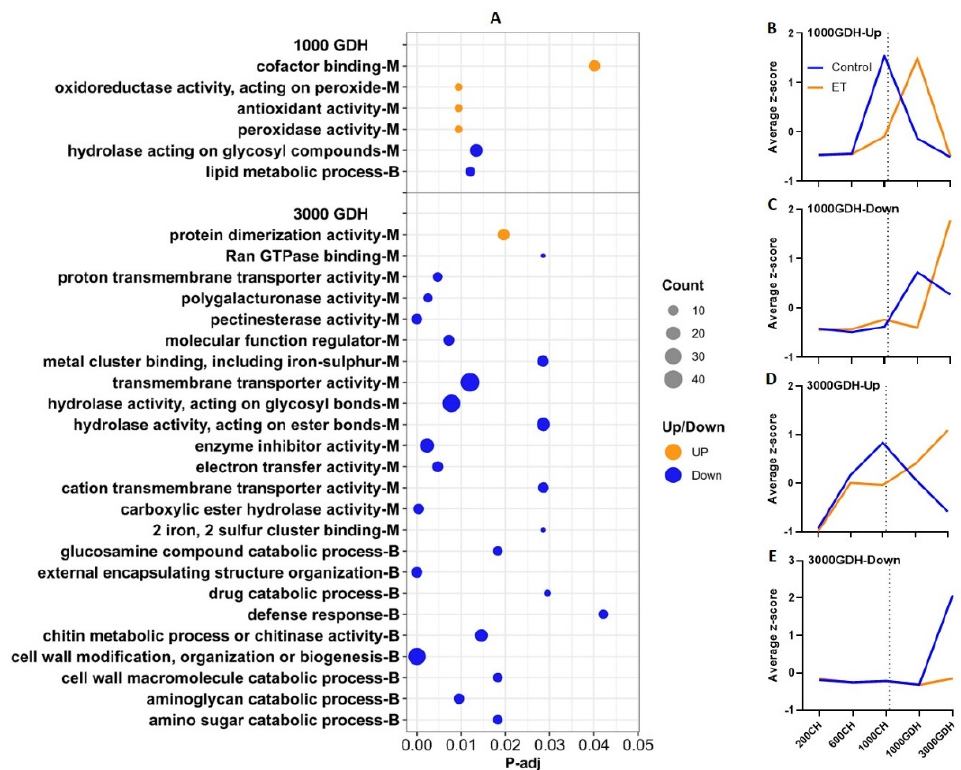
Figure 6. Enrichment analysis of DEGs between the ET treatment and the control of peach cultivar ‘Redhaven’ during endodormancy (1000 and 3000 GDH). Refer to Figure 4 for detailed legend description. ( A ) Significantly enriched GO terms (P-adj < 0.05). Letter B indicates biological processes, and M indicates molecular functions. Dot size represents the number of genes enriched in each GO term. Orange dots represent upregulated DEGs, and blue dots represent downregulated DEGs, respectively. ( B − E ) Mean z-score values of the expression (FPKM) of the DEGs from each group. The dotted lines represent the date of endodormancy release. The expression profiling showed a prominent peak shift in the 1000 GDH upregulation group (Figure 6B), in which the ET treatment and the control yielded nearly identical peaks, with the ET treatment peaking at 1000 GDH, lagging behind the control, which peaked at 1000 CH (Figure 6C), consistent with ET retarding the expression of genes in this group. Similarly, in the 1000 GDH downregulation group, the control peaked at 1000 GDH, while the ET treatment reached a maximum at 3000 GDH. Opposite expression patterns were observed in the 3000 GDH upregulation and downregulation groups, wherein the control peak appeared at 1000 CH, while the ET treatment reached the highest level at 3000 GDH. In the 3000 GDH downregulation group, the control was nearly identical to the ET treatment, but the latter underwent a drastic increase at 3000 GDH (Figure 6D) which was not observed in the control (Figure